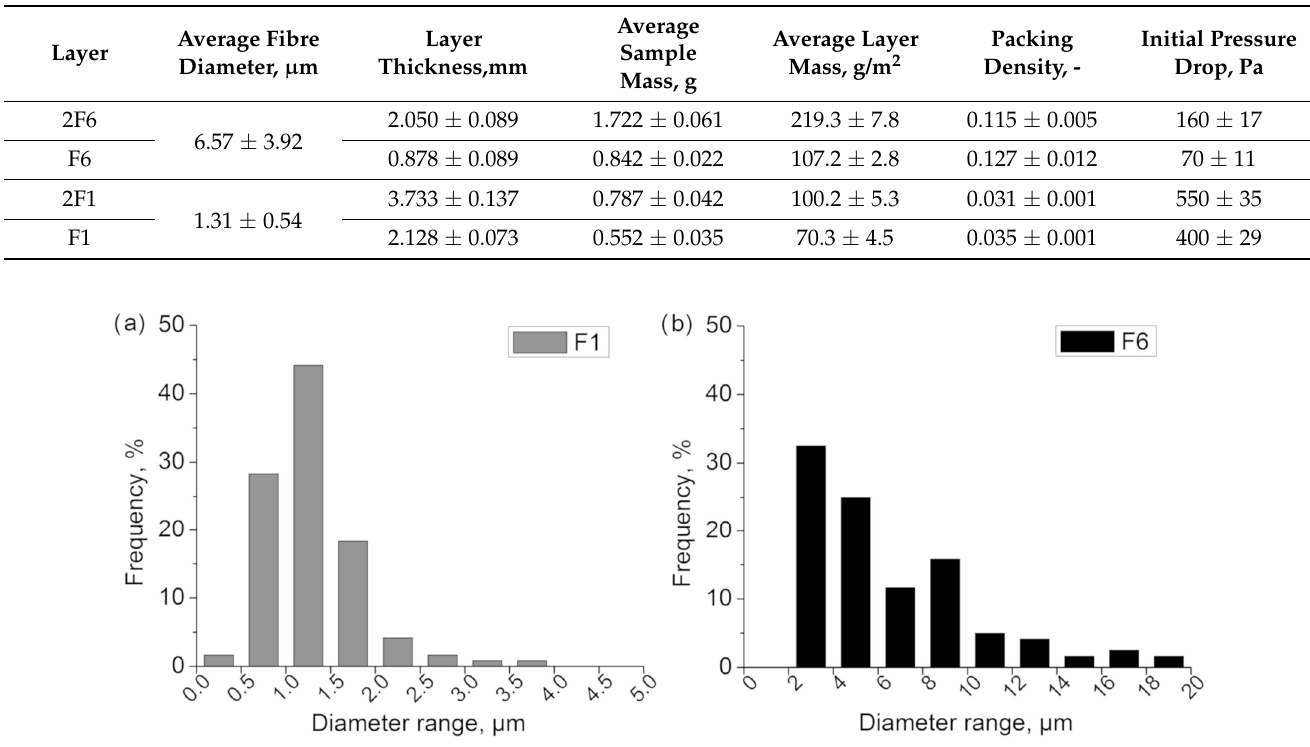
Figure 6. Measured fibre size distribution for ( a ) F1 filter and ( b ) F6 filter.